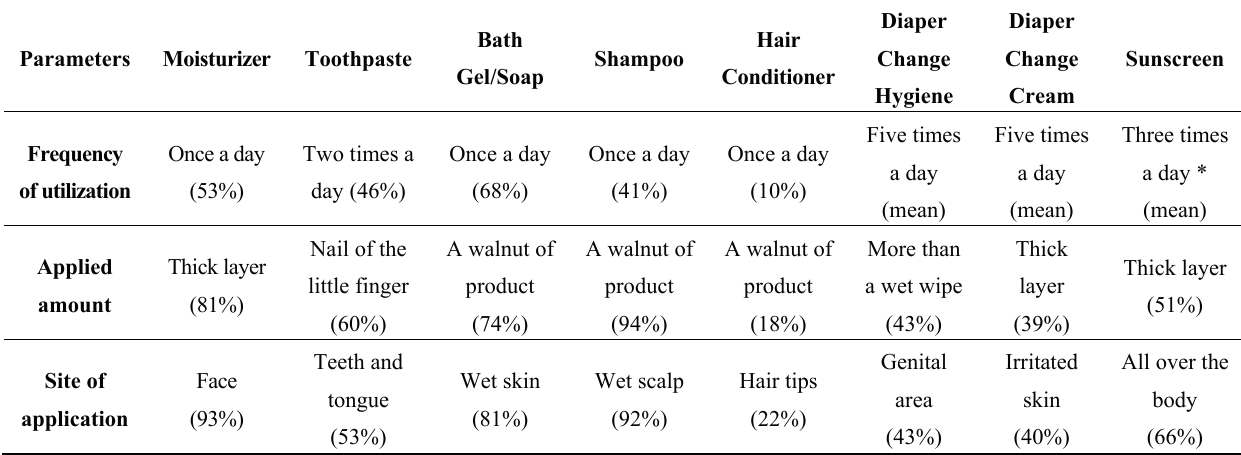
Table 1. Frequency of utilization, applied amount and site of application of personal care products (PCPs) by the inquired children (percentage of answers